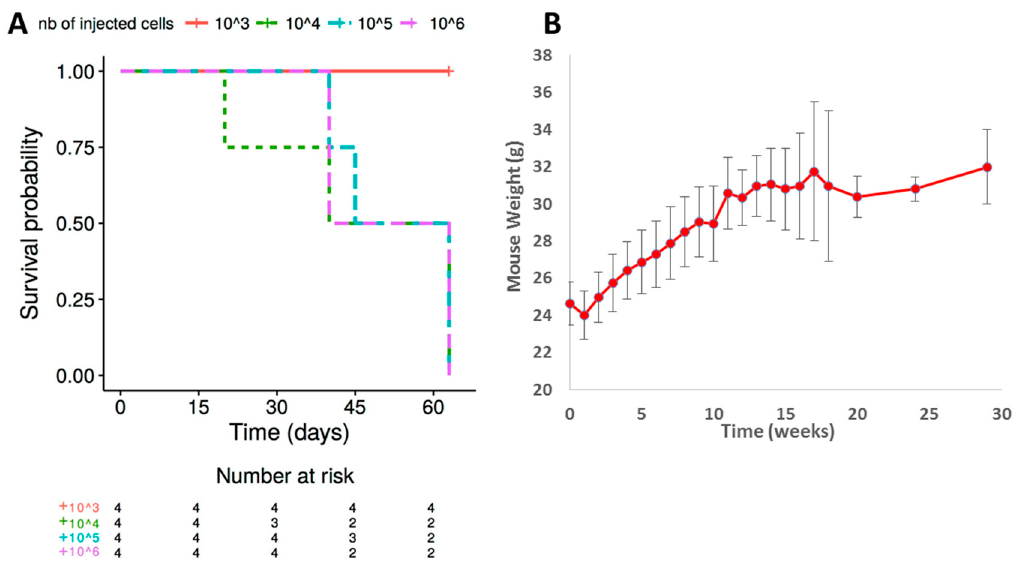
Figure 2. Follow-up of mice injected with L428-c cells. ( A ) Kaplan Meier presentation of mouse survival after injection of various numbers of cells. Mice injected with 10 3 cells showed better tolerability and higher survival than those injected with higher numbers of cells. ( B ) Weight of mice injected with 10 3 cells demonstrating a transient decrease of weight immediately after injection, followed by recovery. Thirty mice were used in this standardization process and evaluated weekly. Standard error bars are shown.